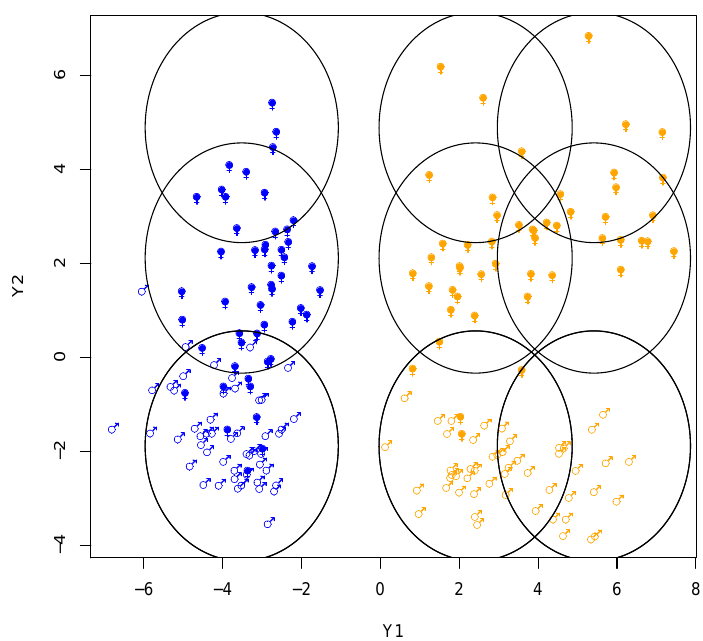
Figure 9. Scatter plots of the clustering subspace on the crabs data for K 1 = 3 and K 2 = 4, 95% isodensity is given for each component resulting of the Cartesian product.